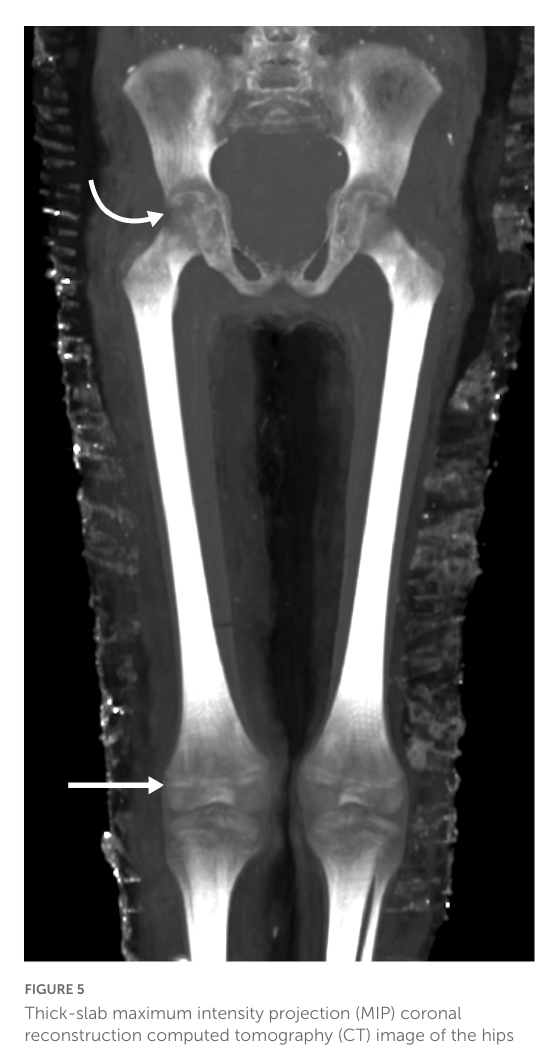
FIGURE5 Thick-slab maximum intensity projection (MIP) coronal reconstruction computed tomography (CT) image of the hips and knees of mummy TR 21/11/16 at the Cairo Egyptian Museum shows non-fusion of the epiphyses. Continuous radiolucent gaps separate the epiphysis and diaphysis at the hip joint (curved arrow) and the knee joint (straight arrow) indicating a juvenile person.